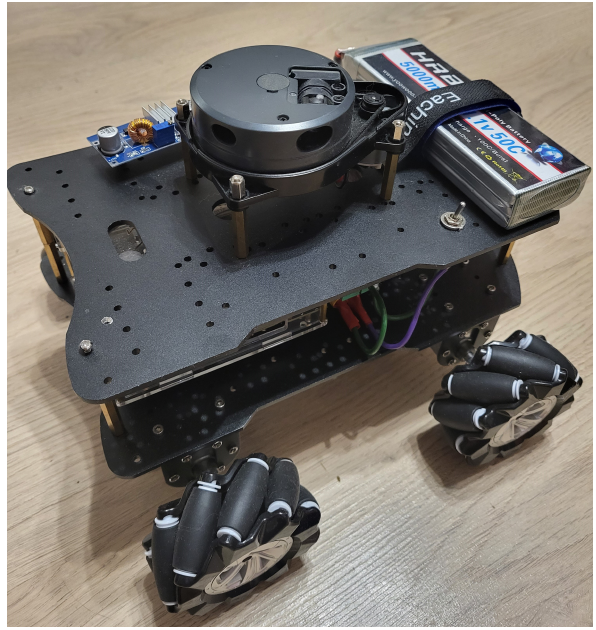
Figure 3. Omni-mecanum-wheeled